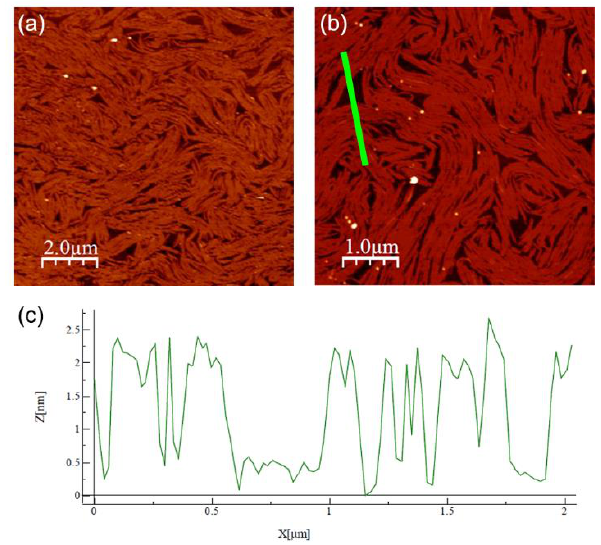
Figure 3. ( a , b ) AFM images of Langmuir–Blodgett films deposited on silicon at Π = 12 mN/m, taken at different positions and magnifications. ( c ) Thickness profile measured along the green bar in ( b ). Table 1. Thickness d , electron density ρ e , and roughness σ of the layer stack used to model the sample: a Si substrate, an intermediate layer of native SiO 2 , and four sections for the BCM film. The thickness and roughness values were provided by the fitting procedure together with the values S = 69.1 Å 2 and n = 1.92. The electron density of each BCM layer was calculated from these values using the model described in the text. The Si substrate parameters and the electron density of SiO 2 were taken from the literature and kept fixed.